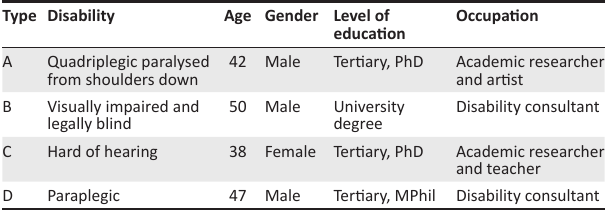
TABLE 1: Profile of study participants ( n =